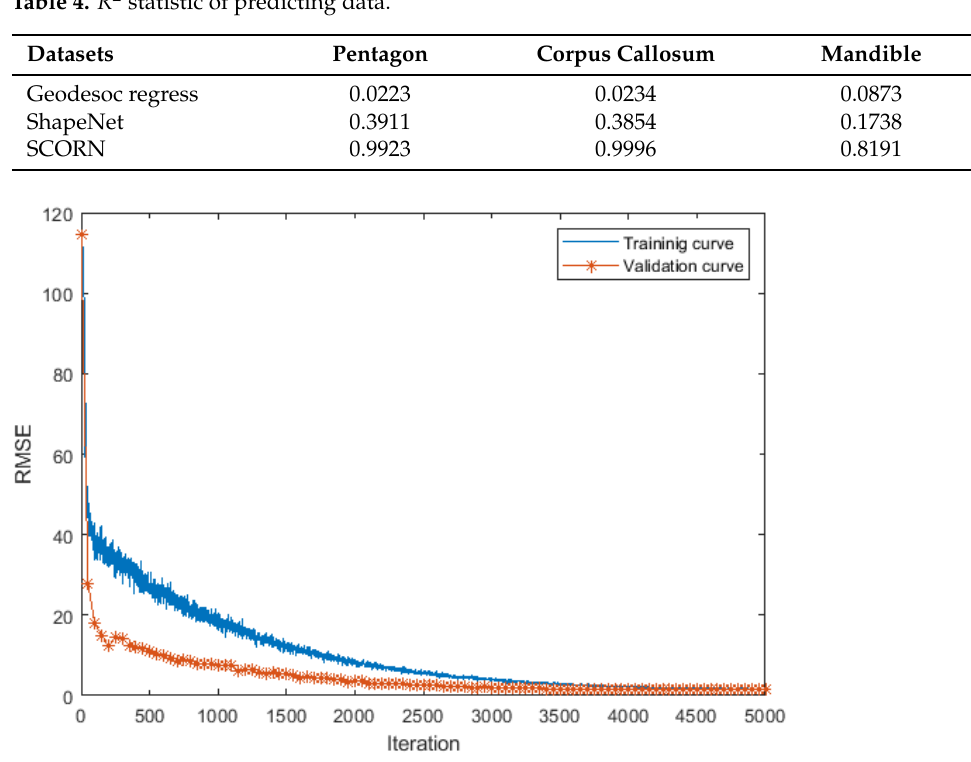
Figure 3. Training and validation